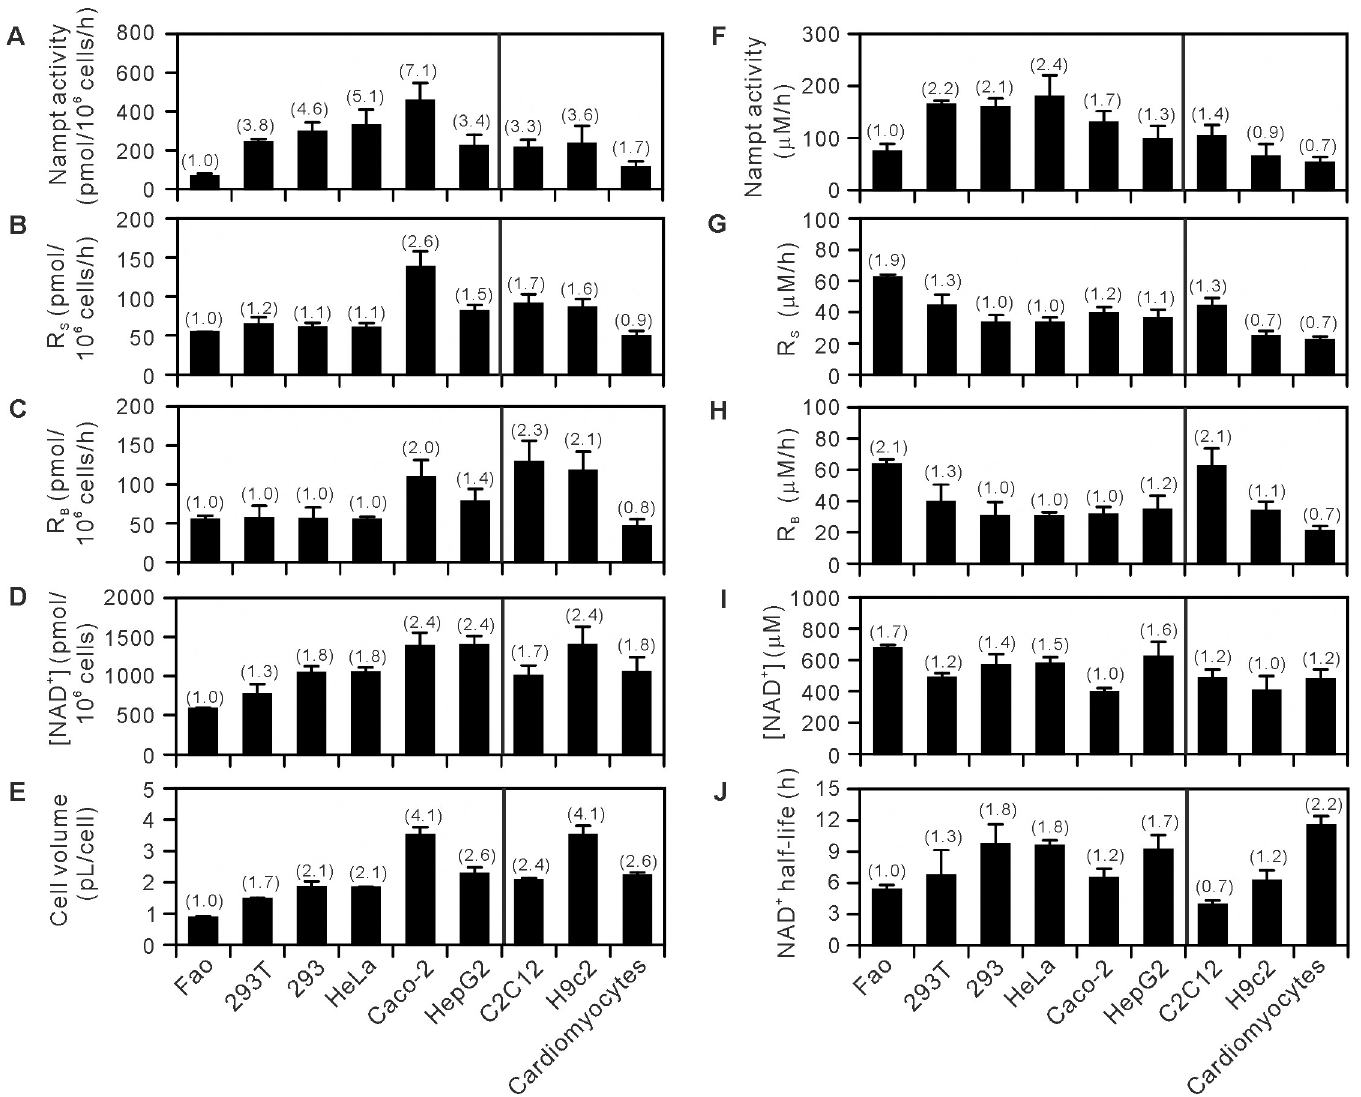
Fig 4. Absolute values of NAD + level, R S , R B , total Nampt activity in mammalian cells. Fao, 293T, 293, HeLa, Caco-2, HepG2, C2C12, H9c2, and the primary cultured cardiomyocytes were incubated in d0-Nam-free MEM supplemented with 2 μ M d4-Nam for 3 h. After the incubation, d3- and d0-NAD + were quantified to determine R S (B) and R B (C) as well as total NAD + content (D). Total Nampt activity was determined in cells incubated with 2 μ M d0-Nam for 3 h (A). The suspended cells were counted using an automated cell counter, which also provides a readout of the approximate volume of the counted cells (E). Total Nampt activity, R S , R B , and total NAD + content were normalized to cell volume to obtain absolute values (F-I). Half-life of cellular NAD + (J) was calculated from R B and cellular NAD + concentration. Data shown are results from 3, 3, 4, 3, 5, 3, 4, 5, and 3 independent experiments for Fao, 293T, 293, HeLa, Caco-2, HepG2, C2C12, H9c2, and the primary cultured cells, respectively. The smallest values within those obtained from Fao, 293T, 293, HeLa, Caco-2, and HepG2 cells in each panel were set to 1.0 and relative values are shown in parentheses.